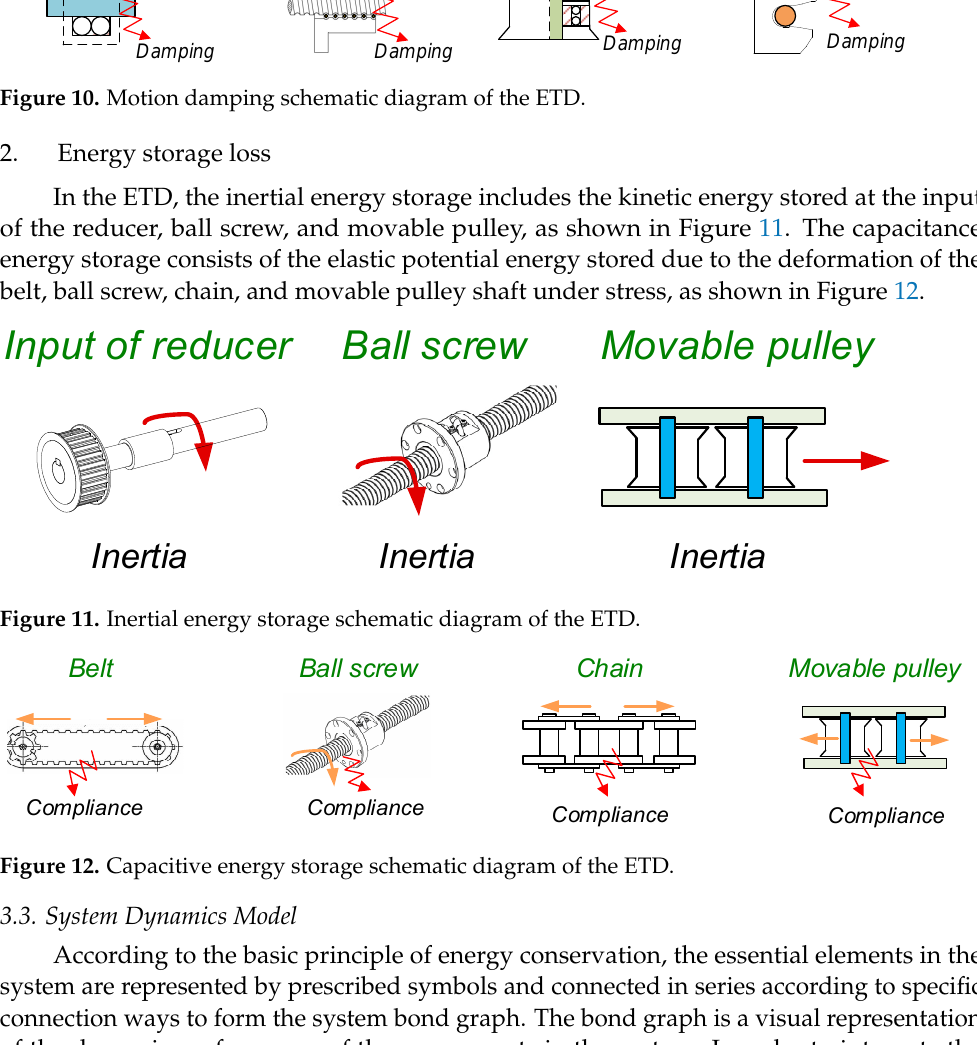
Figure 12. Capacitive energy storage schematic diagram of the ETD.